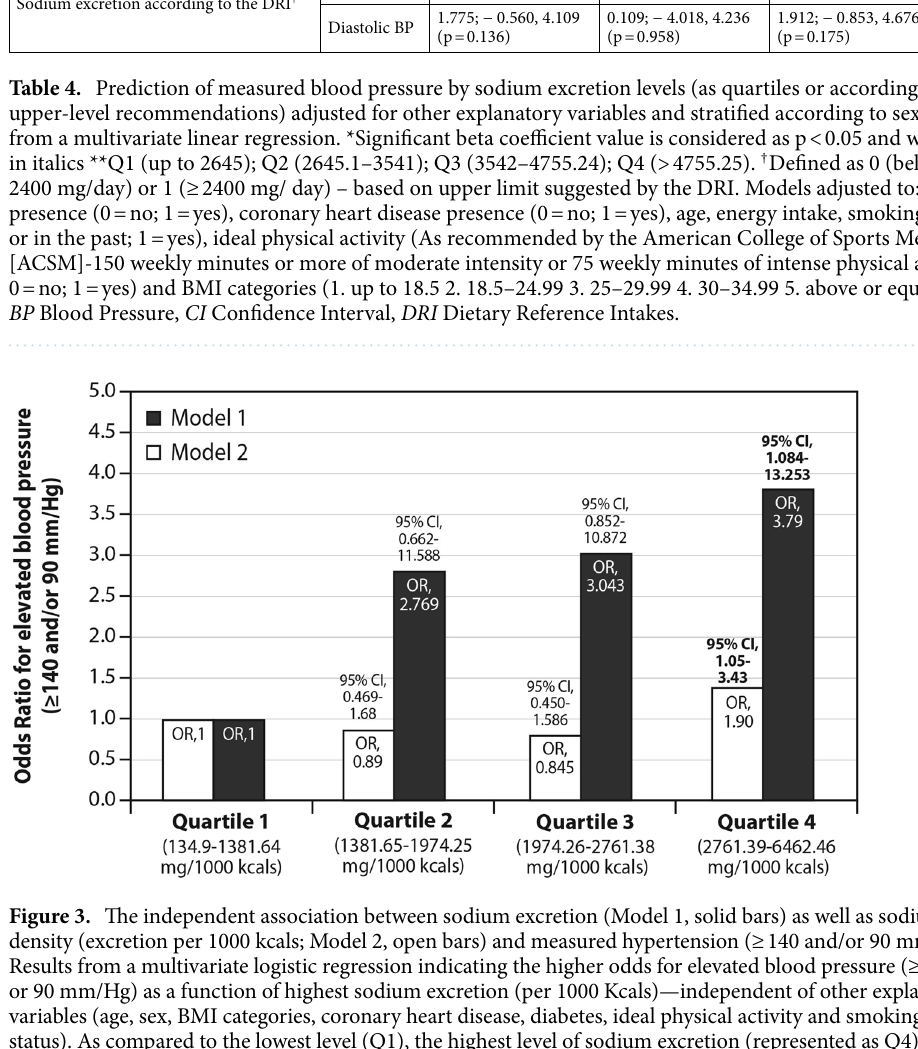
was > 3 folds higher in interviewees whose sodium consumption was at the upper quartile, after adjustment for confounders (hypertension, age, sex, diabetes, CHD, physical activity; Fig. 5). Sodium excretion according to the presence of overweight/obesity and hypertension. Sodium excretion was the highest in overweight/obese hypertensive (blood pressure ≥ 140/90 mmHg) interviewees (4507 ± 1656 mg) [p = 0.001]; compared to non-obese hypertensive (3604 ± 1306 mg) or normotensive interviewees (3593 ± 1604 mg); [p < 0.0001] and compared to overweight/obese normotensive interviewees (4044 ± 1725 mg; p = 0.049) (Fig. 6A). Likewise, the highest sodium density was found in hypertensive subjects who were also